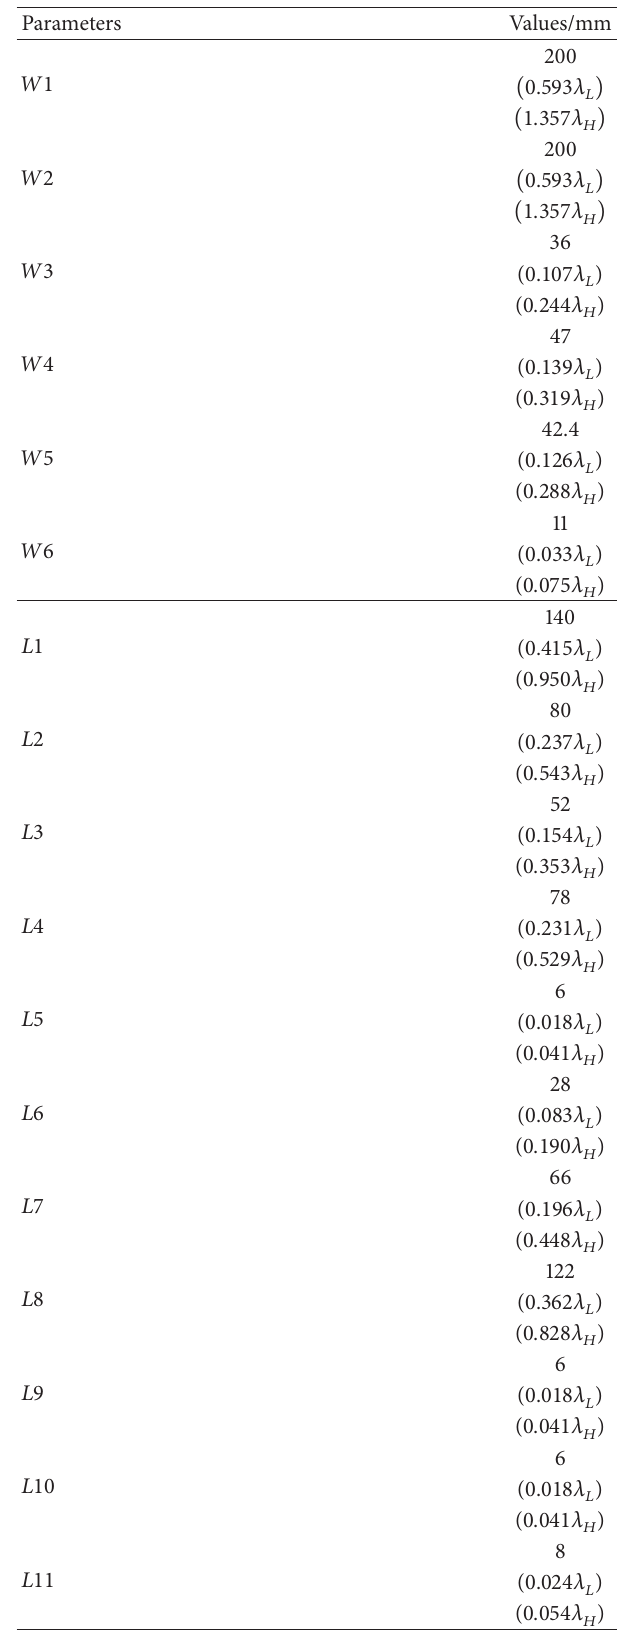
Table 1: Dimensions for the proposed